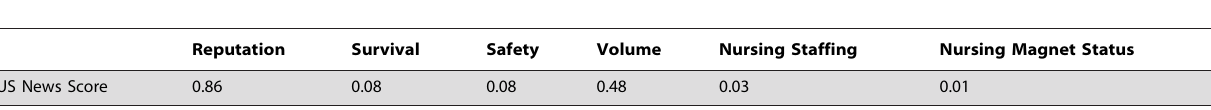
Table 3. Correlation coefficients (R2) from simple linear regressions between the US News and World Report Score and its